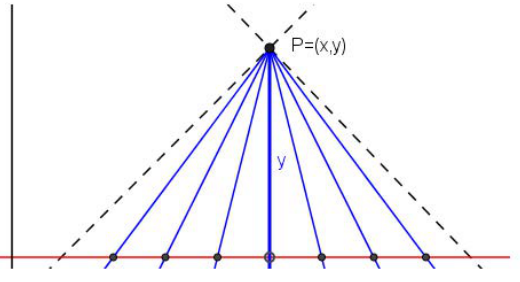
Fig. 2. Spacelike geodesics in L 2 passing through P